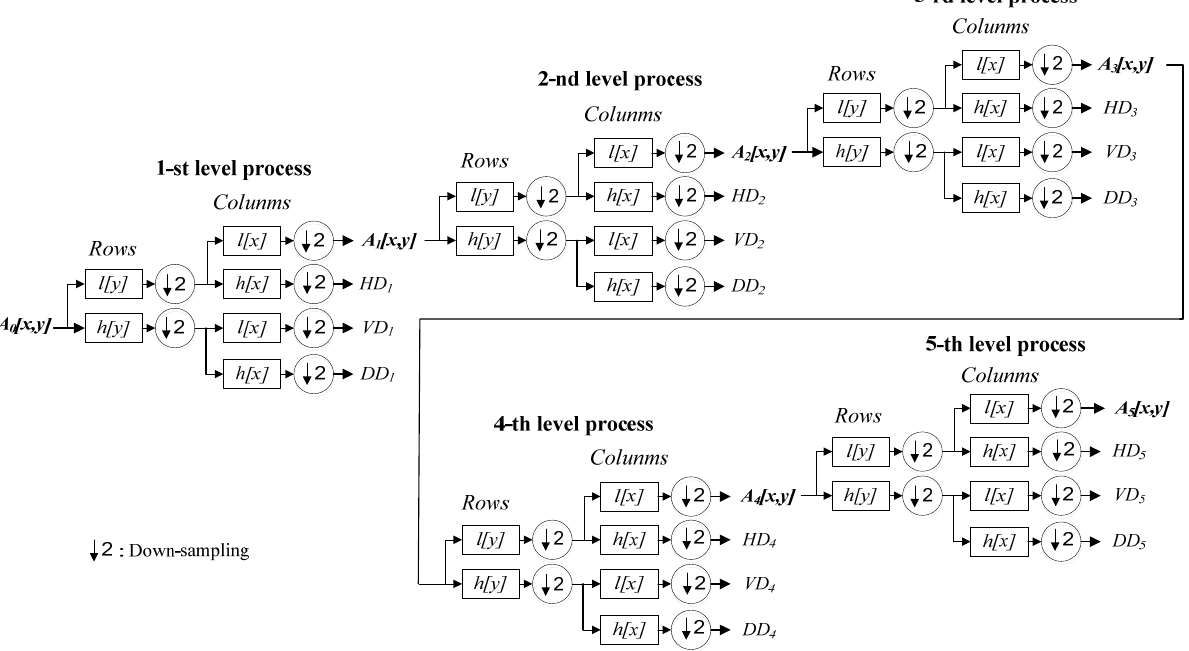
Figure 6. Five-level DWT calculations employed for each of the CCD RGB-IR and depth-grayscale sensor data modalities (flowcharts of the approximate segment in each phase-performed decom- position).